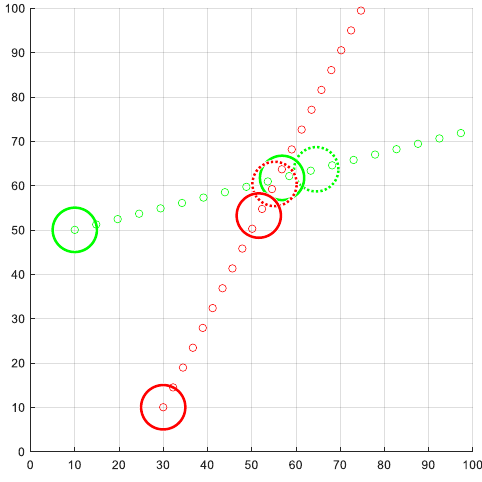
Figure 2. Example of conflict prediction ( 𝑟 = 5 m ; 𝑣 = 10 m/s ). The two UAVs maintain a conflict from 𝑡 = 4.83 s (solid lines) to 𝑡 = 5.63 s (dotted lines).